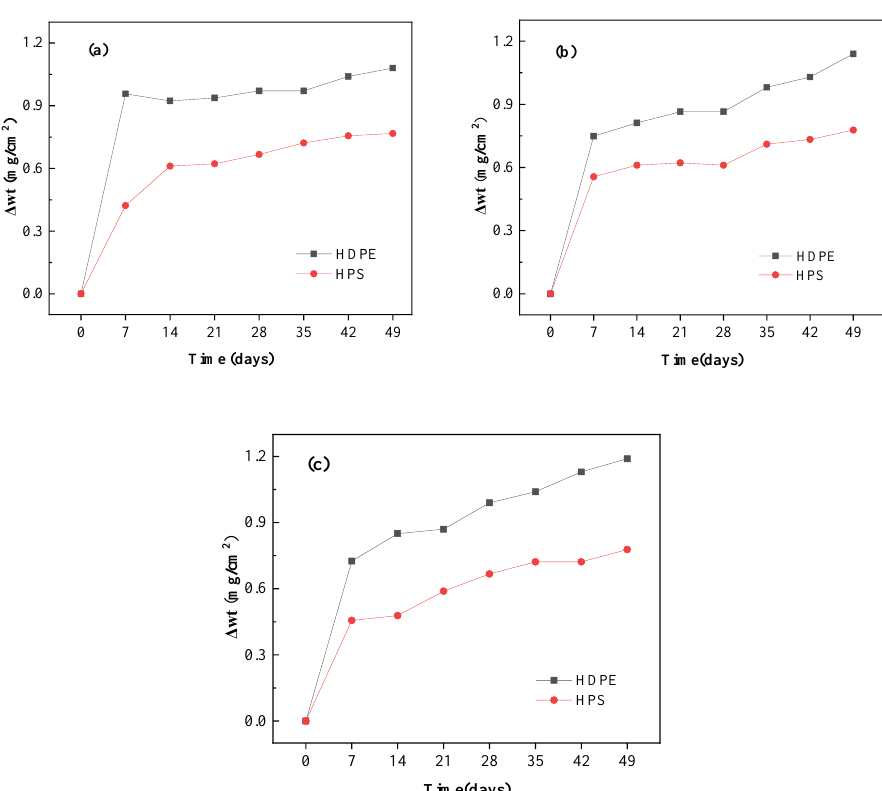
Figure 9. Weight of material samples in simulated leachate under different conditions: ( a ) pH = 4.0; ( b ) pH = 6.8; ( c ) pH = 10.0.